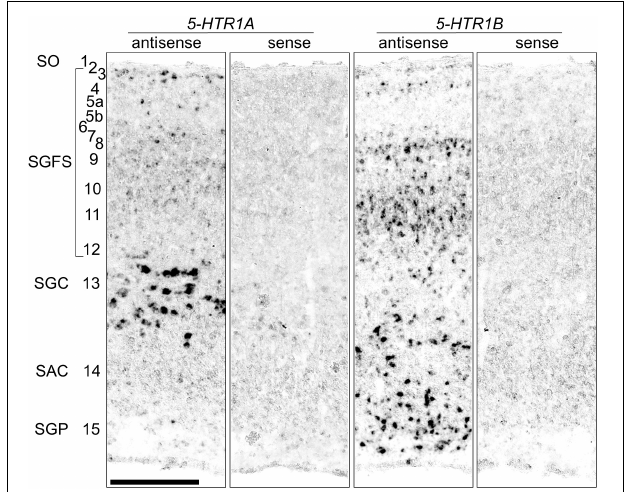
FIGURE 4 | Comparison of the 5-HTR1A and 5-HTR1B expression patterns in the optic tectum in the P1 chick brainstem sections. Magnified views of the regions of the optic tectum to compare layers of 5-HTR1A -expressing and 5-HTR1B -expressing areas. Numbers represent tectal layers according to Ramón y Cajal (1911). The leftmost alphabetical system of nomenclature is in accordance with that mentioned in Kuenzel and Masson’s chick atlas (Kuenzel and Masson, 1988). SAC, stratum album centrale; SGC, stratum griseum centrale; SGFS, stratum griseum et fibrosum superficiale; SGP, stratum griseum periventriculare; SO, stratum opticum; P1, post-hatch day 1. Scale bars = 250 µ